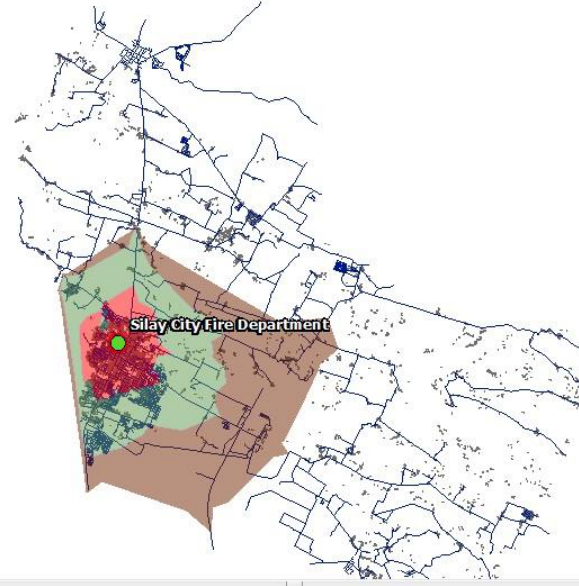
Figure 10. Service area network analysis for Silay City Fire